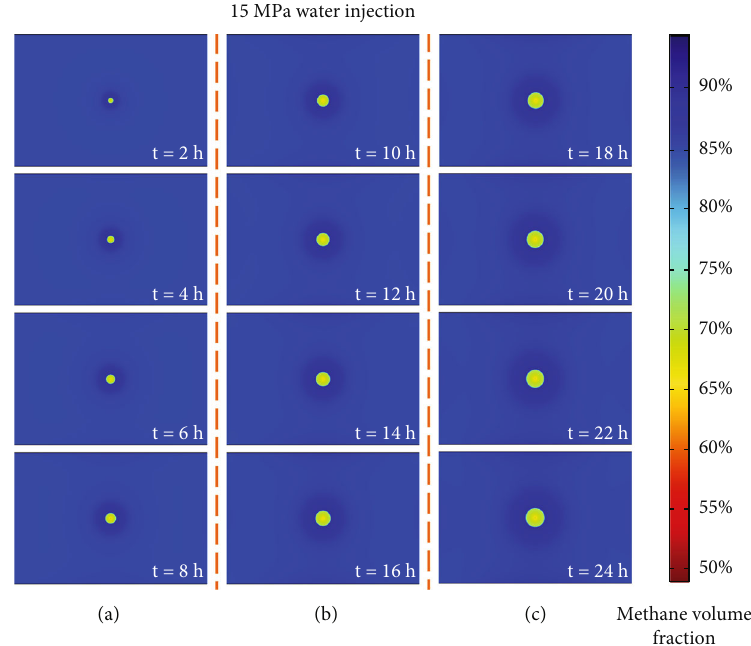
Figure 3: Contour of V